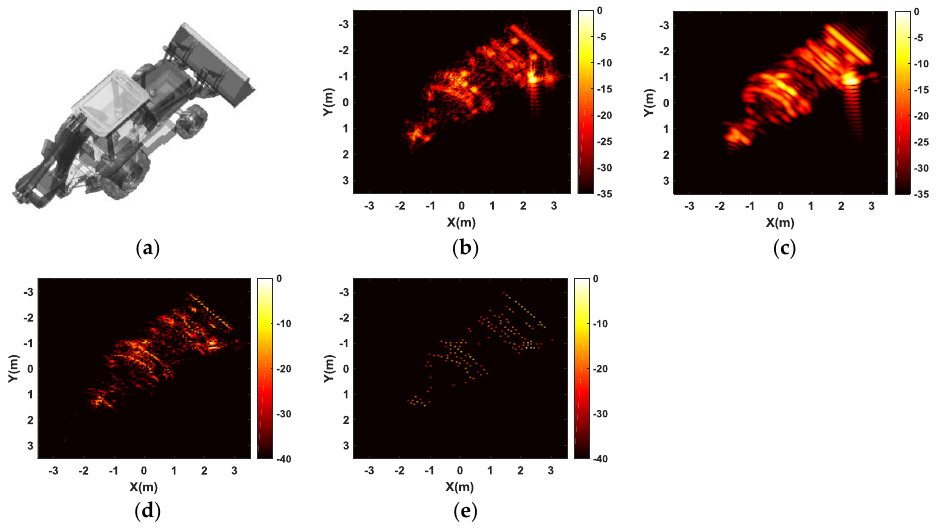
Figure 16. Comparison of imaging results by different imaging methods. ( a ) The backhoe CAD model; ( b ) FBP method applied on the full aperture of 65°; and composite images of ( c ) FBP method; ( d ) independent CS reconstruction and ( e ) joint CS reconstruction of 22 images each corresponding to a sub-aperture of 5°.